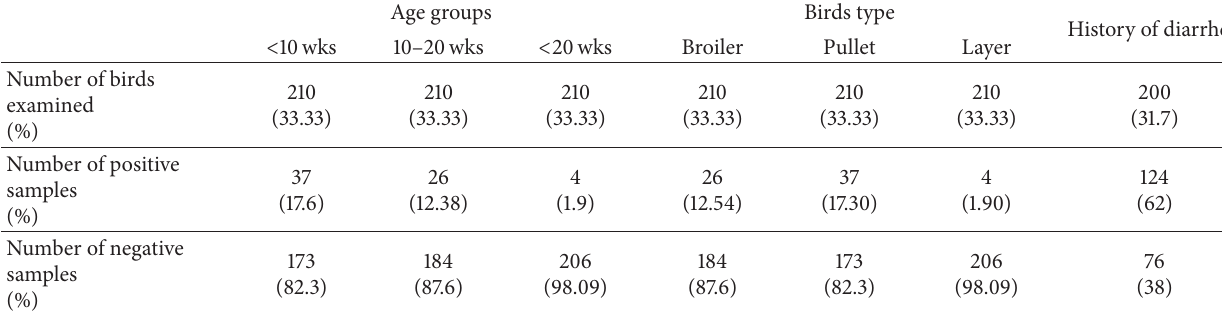
Table 1: Prevalence rate of coccidiosis in free-range chicken in Sidi Thabet,